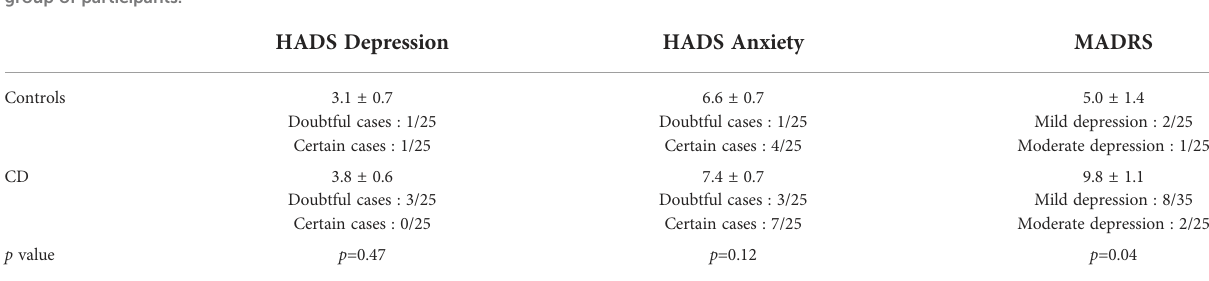
TABLE 4 Mean score in each subscale of the Hospital Anxiety and Depression Scale (HADS) and the Depression Rating Scale (MADRS) for each group of participants. HADS Depression HADS Anxiety